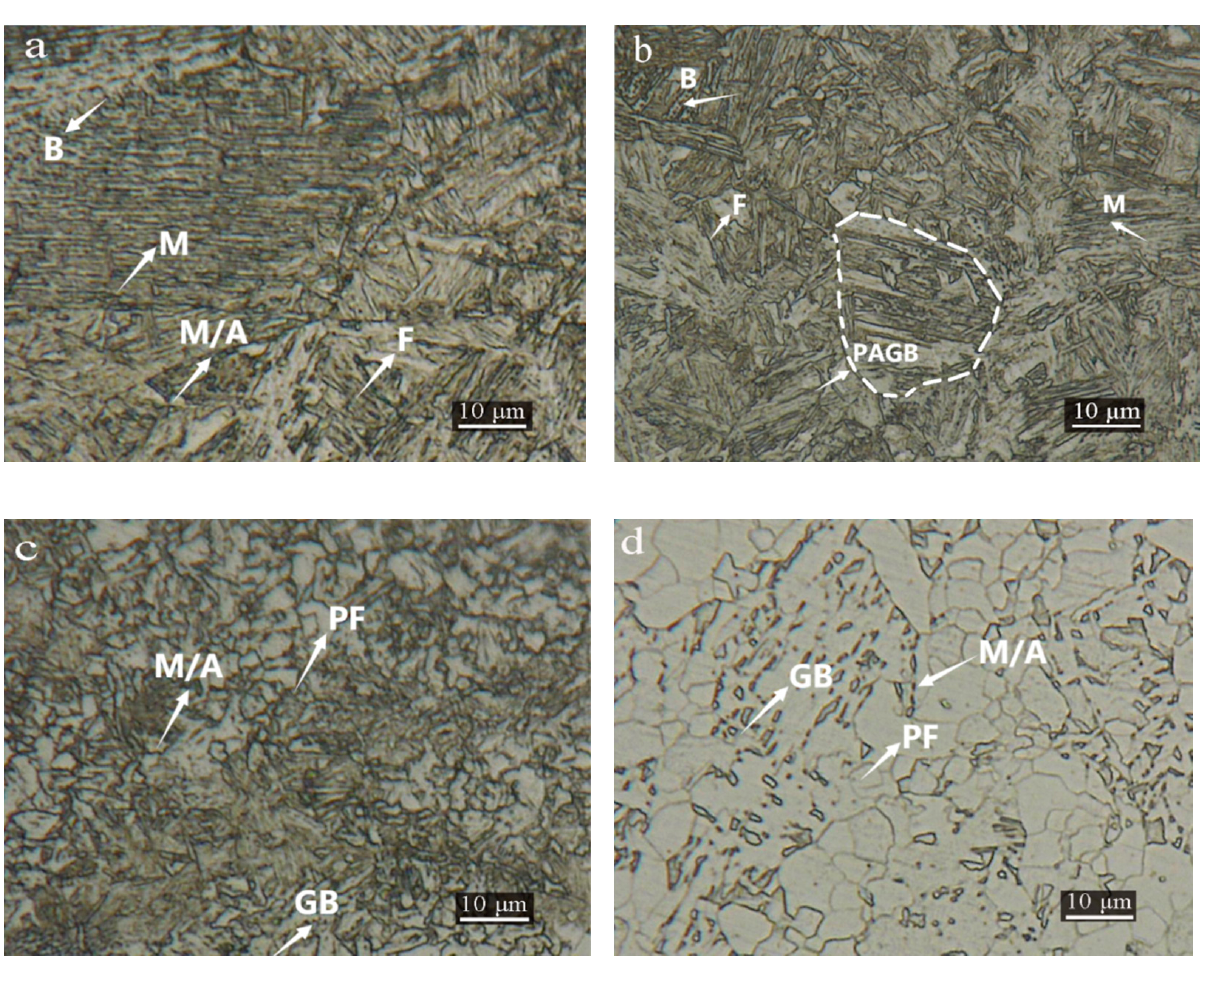
Figure 4. Microstructure of the X80 pipeline steel welded joint with the heat input of 2.86 kJ/cm: ( a ) welded metal; ( b ) CGHAZ; ( c ) FGHAZ and ( d ) BM. The microstructure of the as-received BM was polygonal ferrite (PF) with fine equiaxed grains and granular bainite (GB) with embellished by martensite (M) plates and retained austenite (so called M/A islands) as the secondary phase. The microstructure characteristics were formed by thermomechanically controlled processing (TMCP) [18]. The uniform distribution of fine mild microstructure of PF and hard microstructure of GB gives the pipeline steel better performance, including high deformability in particular. In the WM with different heat inputs, the types and sizes of microstructure vary widely. The microstructure transforms from low-carbon martensite with lath spacing less than 1 µ m to fine-grained acicular ferrite with the increase in heat input, and bainite (B) changes from lath to granular. In addition, the M/A composition also changed from chains to islands and was evenly distributed around the ferrite (F)